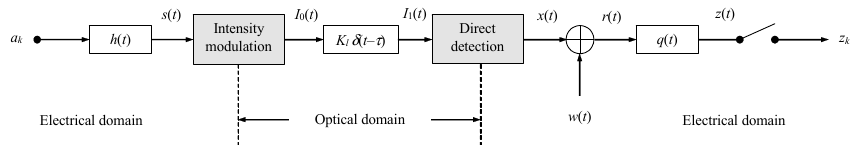
Figure 2. Signal model for optical intensity links.